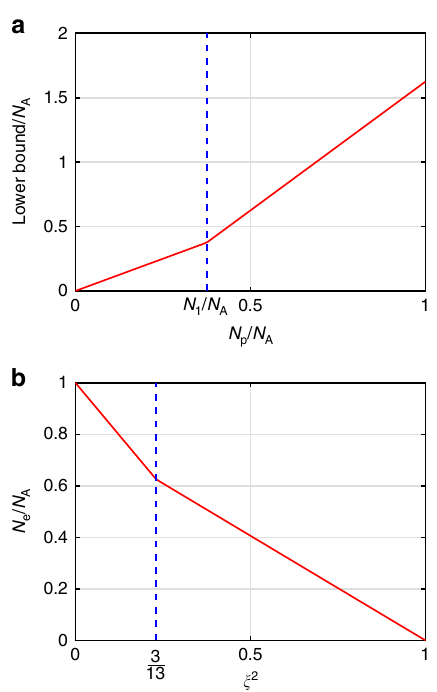
Fig. 5 Entanglement witness. a Lower bound on the sum of the three variances given in Eq. (13) as a function of N p for a quantum state of the type given in Eq. (10). We set N 1 / N A = 3/8, F 1 = 1, F 2 = 2, corresponding to the experiment. If we had only particles with the same spin, it would just be a straight line. b The lower bound on the number of entangled spins, given in Eq. (16), as a function of the spin-squeezing parameter ξ 2 representing a differential Wiener increment. In our experiments the photocurrent I ( t ) is sampled at a rate Δ − 1 = 200 k Samples/s. To formulate the discrete-time